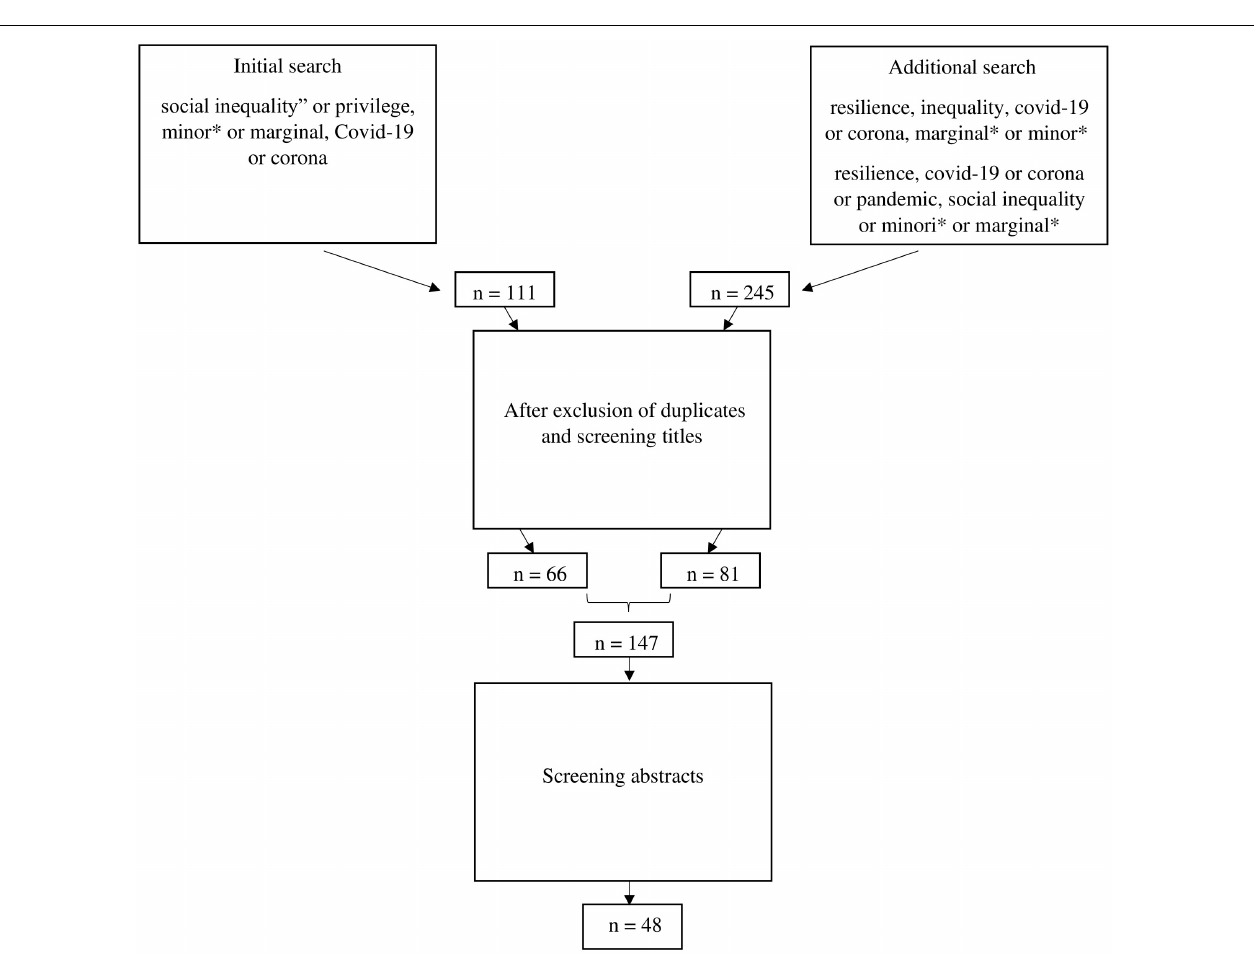
FIGURE 1 | Search